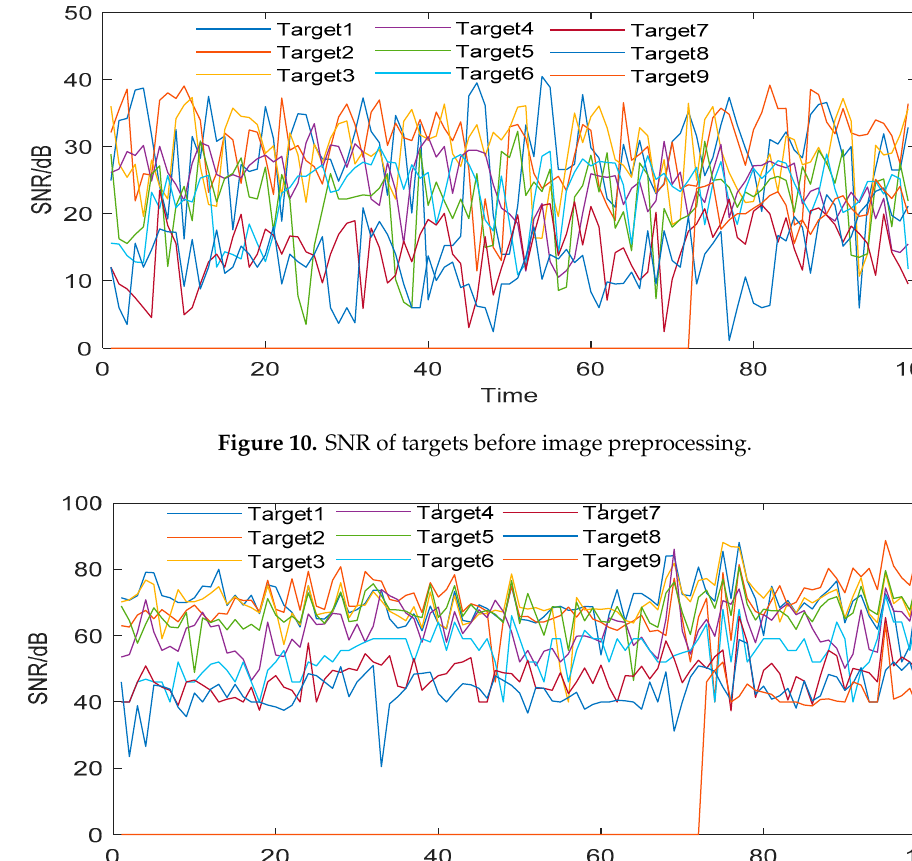
Figure 11. SNR of targets after image preprocessing.